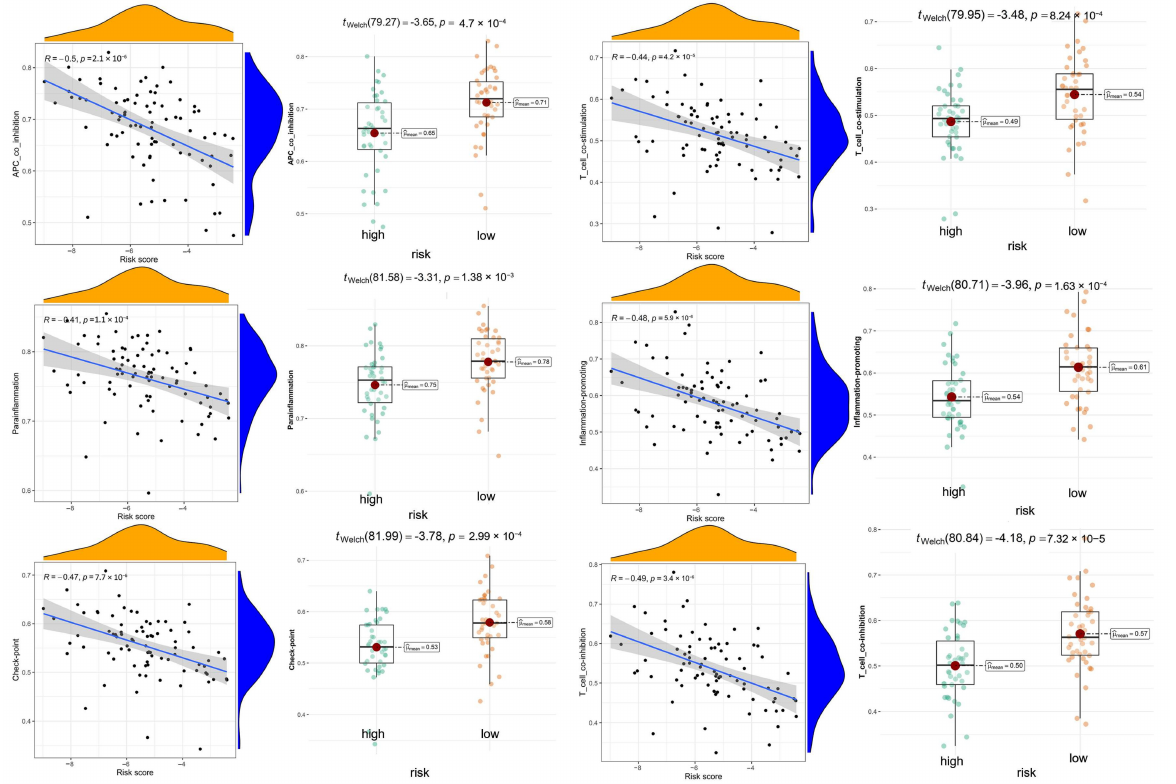
Figure 12. The association between immune functions and risk scores and immune function scores between different risk subgroups.